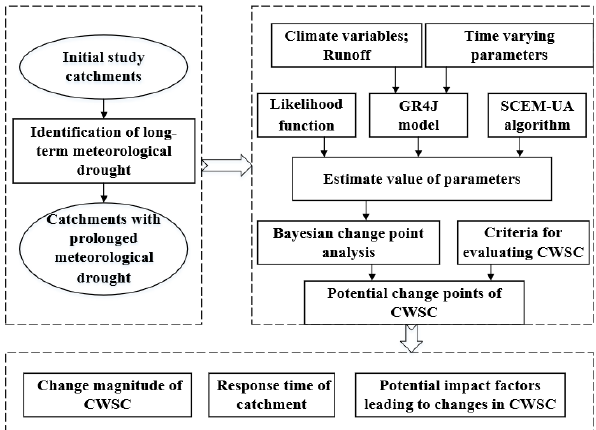
Figure 3. Flowchart of the proposed methodology and procedures.